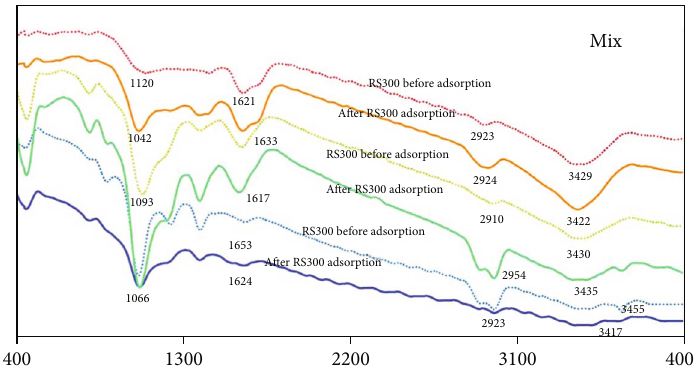
Figure 14: Adsorption mechanism of mixed metal ions in acidic solution of straw.